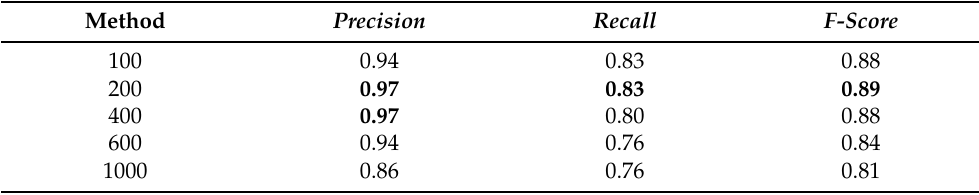
Table 7. The performance of the MTCformer with different word vector dimensions. Method Precision Recall F-Score 100